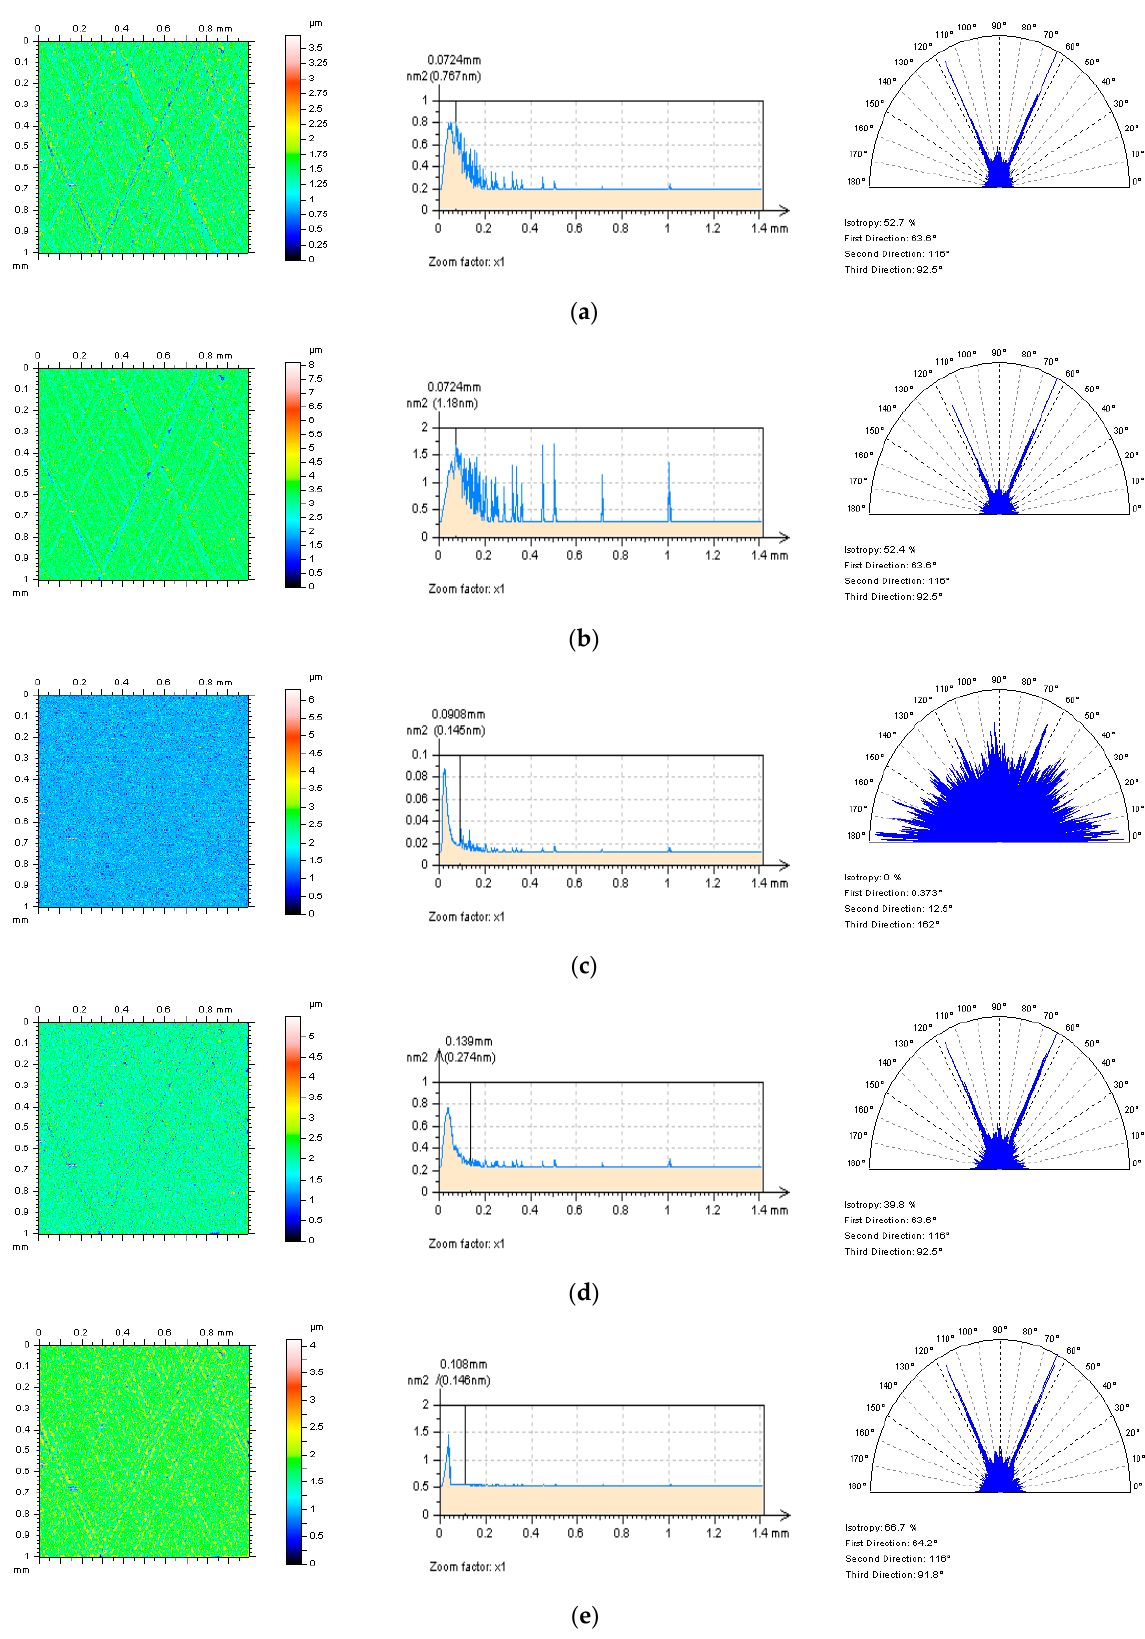
Figure 10. NSs (left), PSDs (middle) and texture direction graphs (right column), defined for results of measurement (0.7 mm/s) of the zero-wear plateau-honed cylinder liner surface topography, received by the application of GF ( a ), RGF ( b ), DMF ( c ), SF ( d ) and FFTF ( e ), cut-off = 0.035 mm.